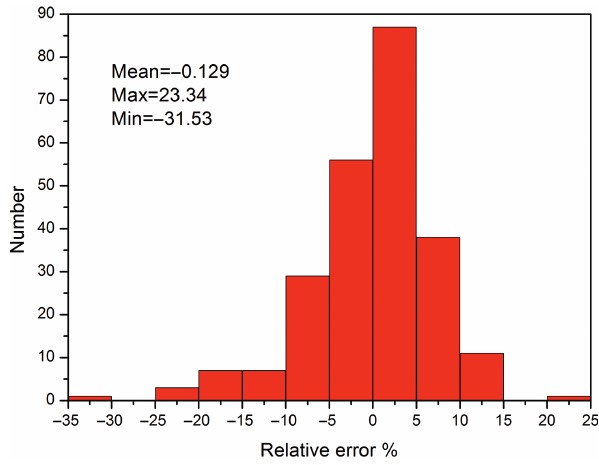
Figure 16: Statistical analysis of the relative error.